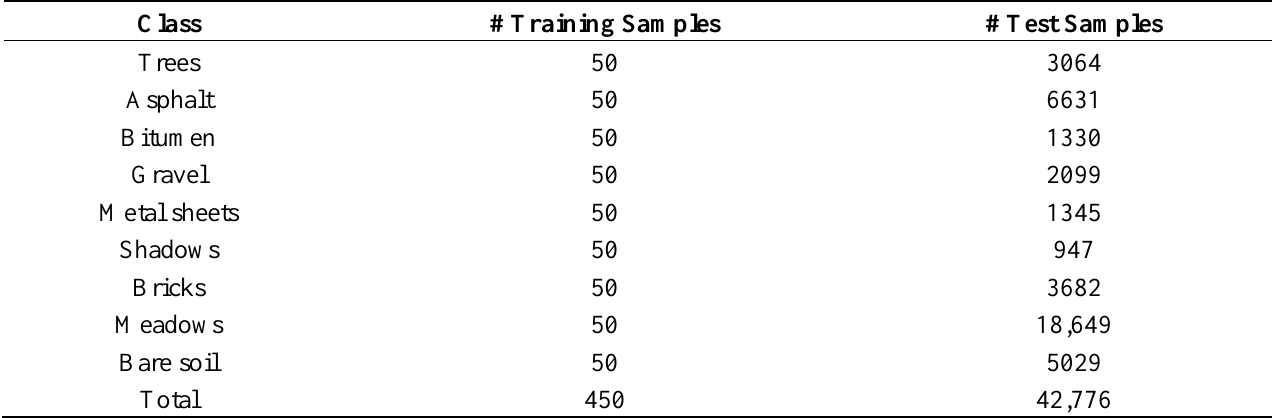
Table 3. Numbers of samples for the Pavia University image.